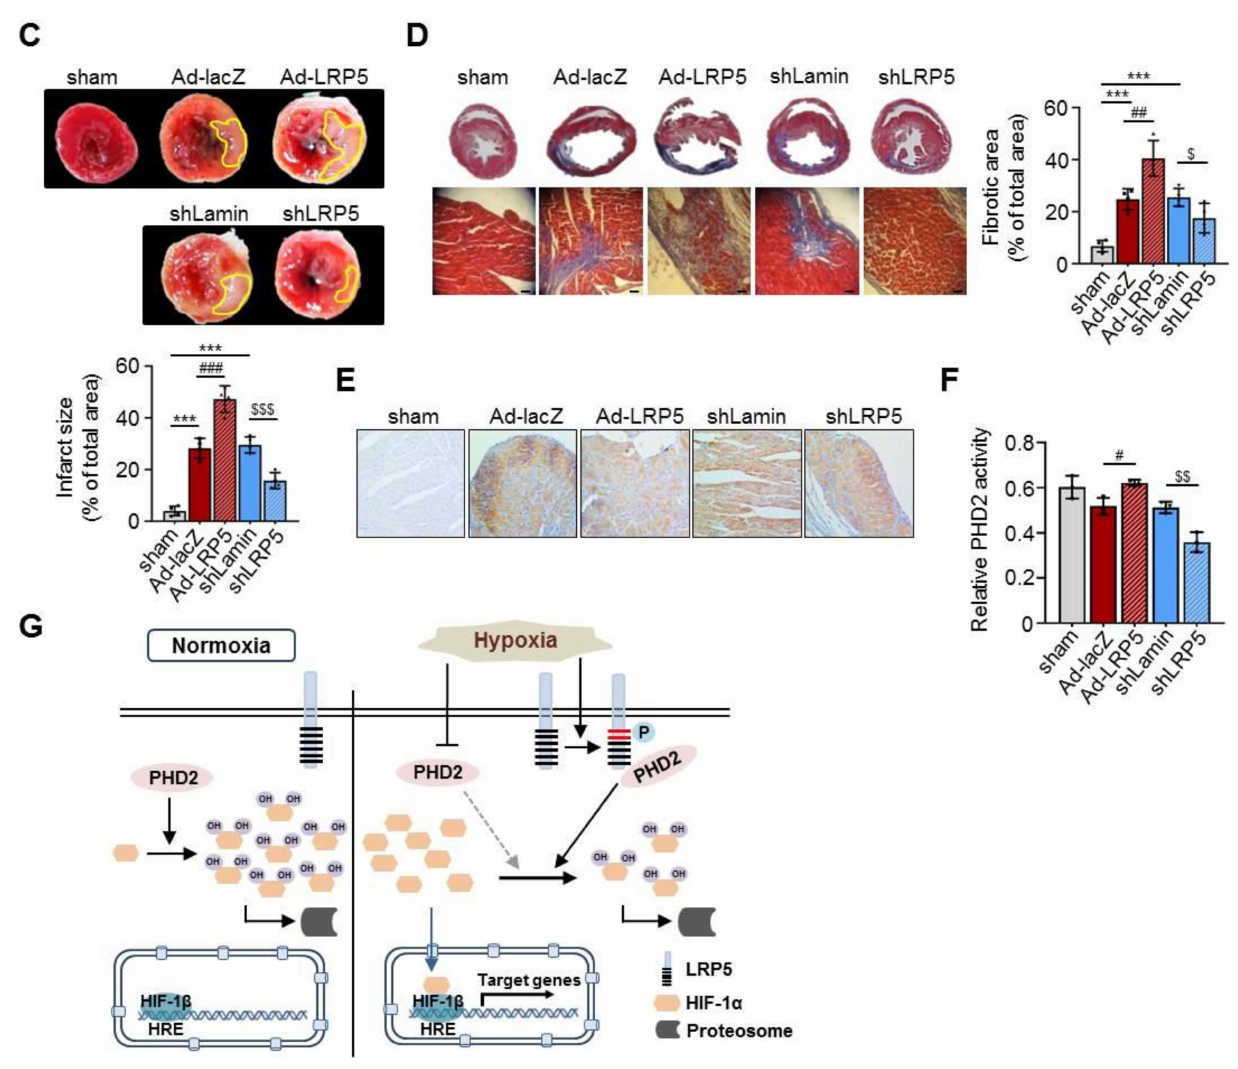
Figure 7. LRP5 silencing protects I/R injury in vivo. ( A ) Representative image of pressure–volume loop analysis. ( B ) Statistical analysis of the results from the hemodynamic analysis, including ejection fraction (EF), heart rate, dp/dt max, and dp/dt min in each group. n = 5–8 rats/group. Means ± SD. * p < 0.05, *** p < 0.001 versus sham control; # p < 0.05, ## p < 0.01 Ad-LRP5 versus Ad-lacZ; $ p < 0.05 shLRP5 versus shLamin; NS, no significance. ( C ) Representative photographs of TTC-stained myocardium sections from each experimental group. LV infarct size (white areas) is presented as a percentage of the total ventricular area. n = 4 rats/group. Means ± SD. *** p < 0.001 versus sham control; ### p < 0.001 Ad-LRP5 versus Ad-lacZ; $$$ p < 0.001 shLRP5 versus shLamin. ( D ) Representative Masson’s trichrome-stained images two weeks after I/R operation. Quantification is expressed as the percentage of fibrosis from the total area. Scale bars: 100 µ m. n = 4 rats/group. Means ± SD. *** p < 0.001 versus sham control; ## p < 0.01 Ad-LRP5 versus Ad-lacZ; $ p < 0.05 shLRP5 versus shLamin. ( E ) Representative images of HIF-1 α immunohistochemical staining in each experimental group. ( F ) Biotinylated HIF-1 α oxygen-dependent degradation domain and hydroxylated control peptide were detected using TMB substrate at 650 nm. n = 4 rats/group. Means ± SD. # p < 0.05 Ad-LRP5 versus Ad-lacZ; $$ p < 0.01 shLRP5 versus shLamin. ( G ) Schema of LRP5-mediated HIF-1 α stability regulation under hypoxia. Under normoxia, PHD2 hydroxylates HIF-1 α ; then, proteasomal degradation of HIF-1 α is facilitated. Under hypoxia, the hydroxylated activity of PHD2 is blocked and HIF-1 α is stabilized. However, the phosphorylation of LRP5 at S1503 is increased and interacted with PHD2 under hypoxia, leading to maintenance of its hydroxylated activity. Consequently, HIF-1 α is still partly degraded. All images shown are representative of those obtained from at least three independent